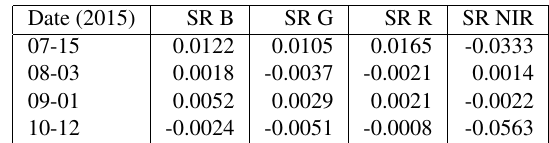
Table 2: Mean difference between field spectrometer and satellite values when comparing the spectrally synthesized field spectrom- eter pixels with the original Operational Land Imager (OLI) val- ues. Satellite reflectances are subtracted from those synthesized. mean “blue”, “green”, “red” and “near-infrared”,